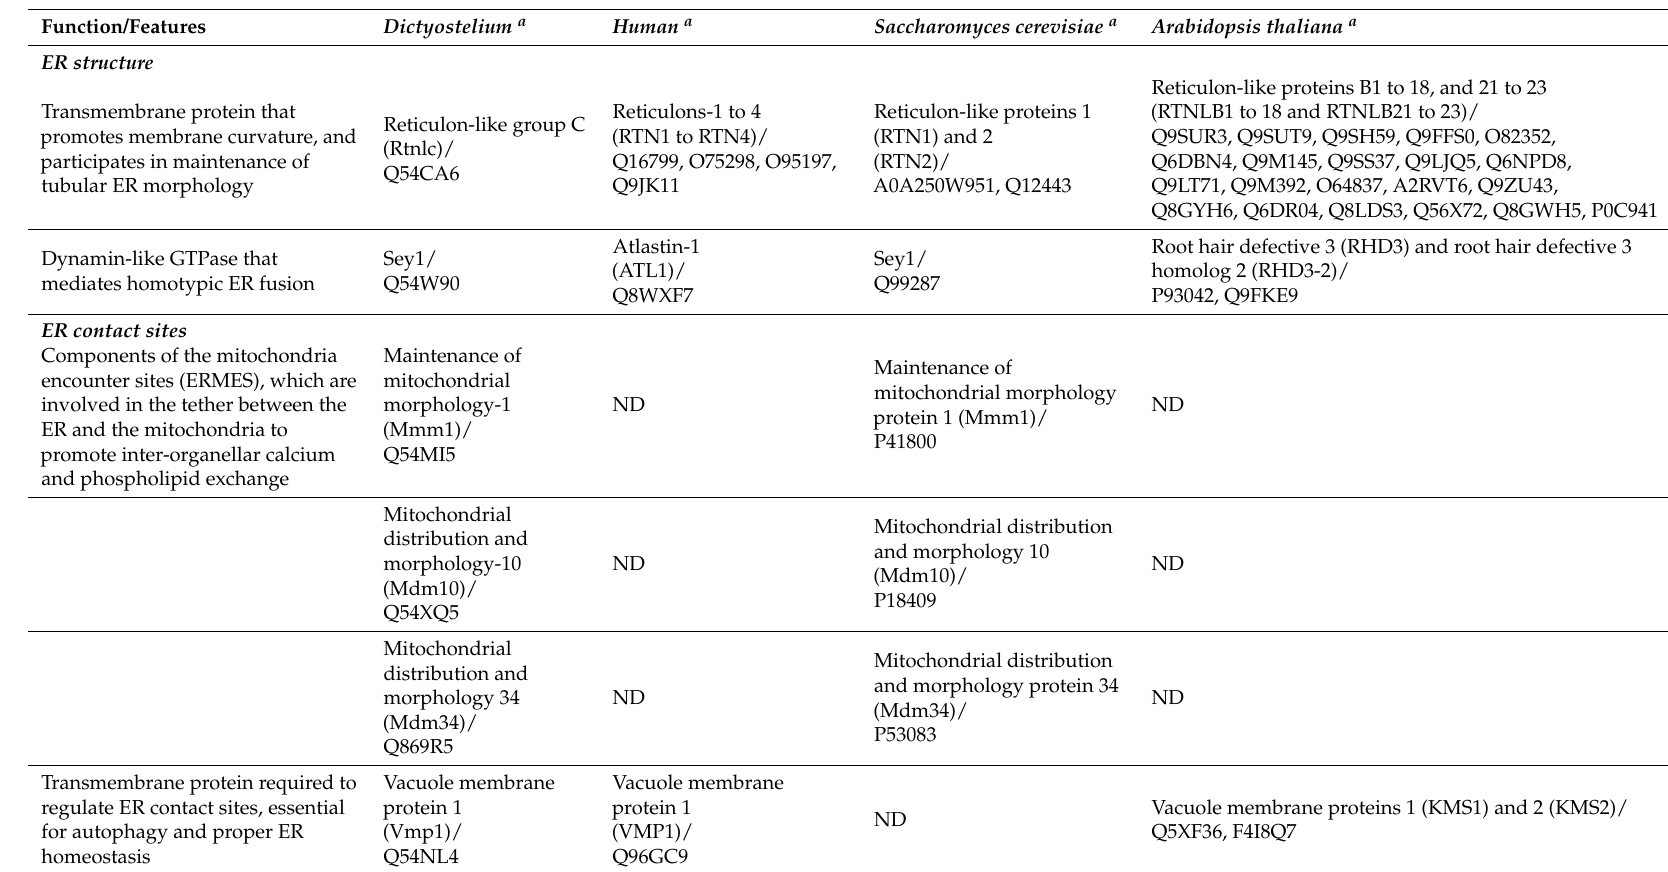
Table 1. List of the endoplasmic reticulum (ER) protein orthologs mentioned throughout this